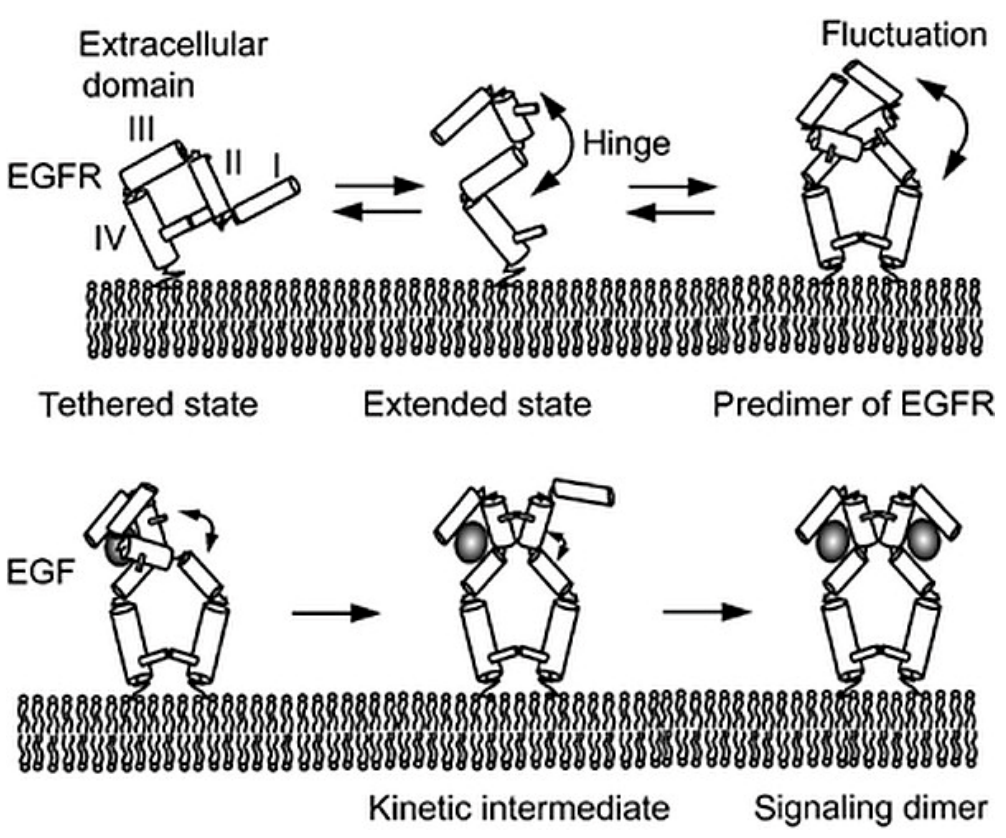
Figure 6. Model for the formation of signaling dimer EGF/EGFR complexes (figure from Teramura et al. [89]). The EGFR fluctuates between the tethered and extended states, and can form predimers that stabilize the extended state. The binding of a single EGF to a predimer results in a conformational change, increasing the affinity for a second EGF.